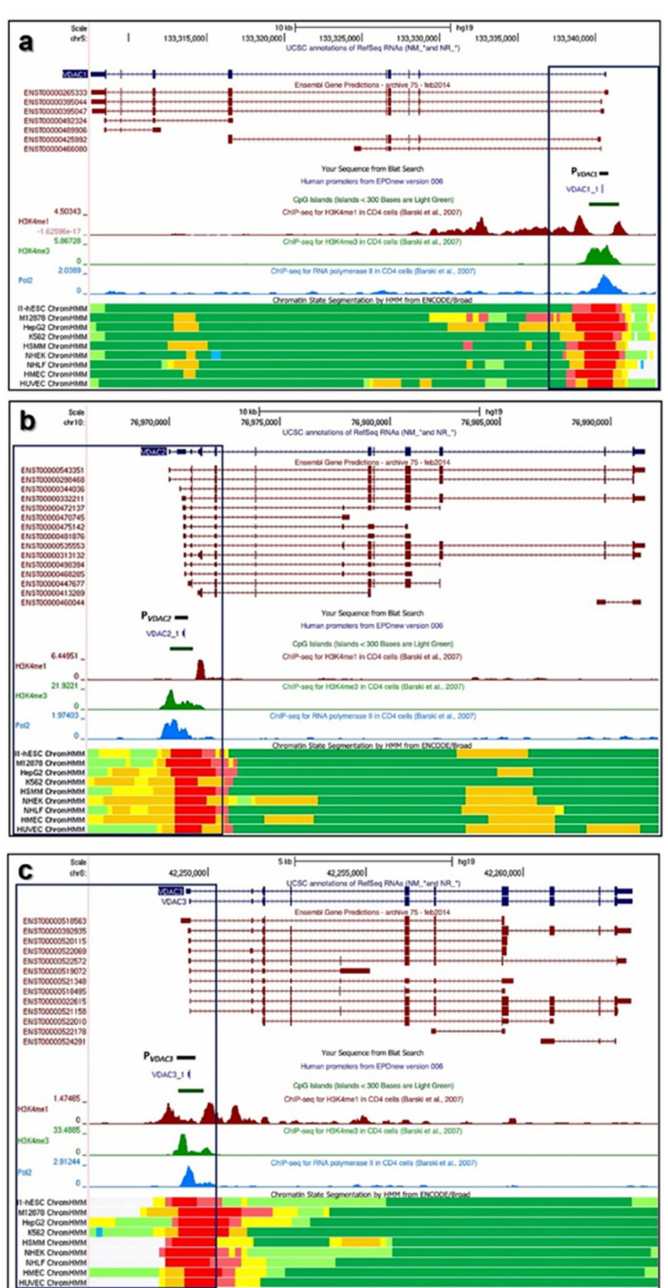
Figure 1. Human VDAC (voltage-dependent anion-selective channels) isoforms gene structures and functions. Overview of the gene structure of human VDAC isoforms and their most relevant functional and structural sites. ( a ) hVDAC1 gene location on Chr5:133,340,230-133,340,830 (GRCh37 / hg19) from UCSC Genome Browser; ( b ) hVDAC2 gene location on Chr10:76,970,184-76,970,784; hg19; ( c ) hVDAC3 gene location on Chr8:42,248,998-42,249,598; hg19. In each panel, a black box encloses the 600 bp promoter sequence indicated as P VDAC1 , P VDAC2 , and P VDAC3 , respectively, and aligned with the annotated sequence from EPDnew (v.006). This allows the profile of transcriptional activity of the gene promoter region to be highlighted by CpG island identification, levels of enrichment of the H3K4me1 and H3K4me3 histone marks, and RNA Pol2 and Chromatin State Segmentation ChIP-seq data. Functional elements of Chromatin state segmentation by HMM of nine di ff erent cell lines are identified using di ff erent colors as follows: bright red: active promoter; light red: week promoter; orange: strong enhancer; yellow: weak / poised enhancer; blue: insulator; dark green: transcriptional transition / elongation; light green: transcriptional